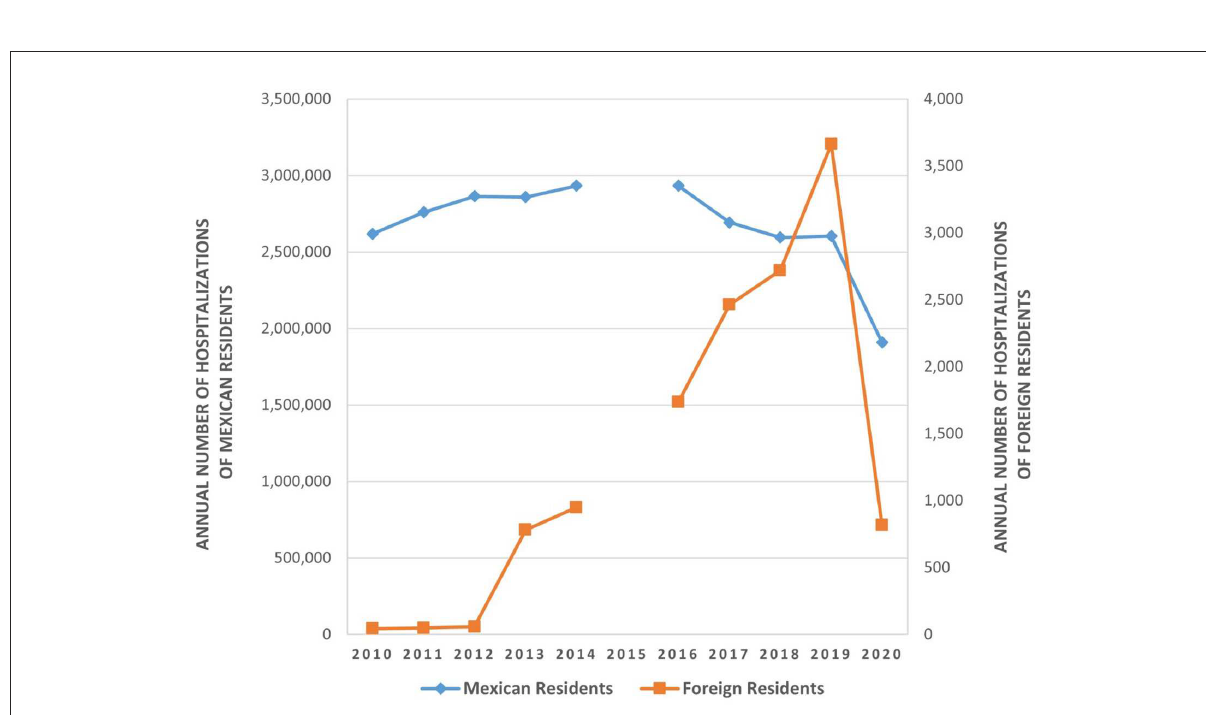
FIGURE2 Trends in hospitalizations among Mexican and foreign residents,